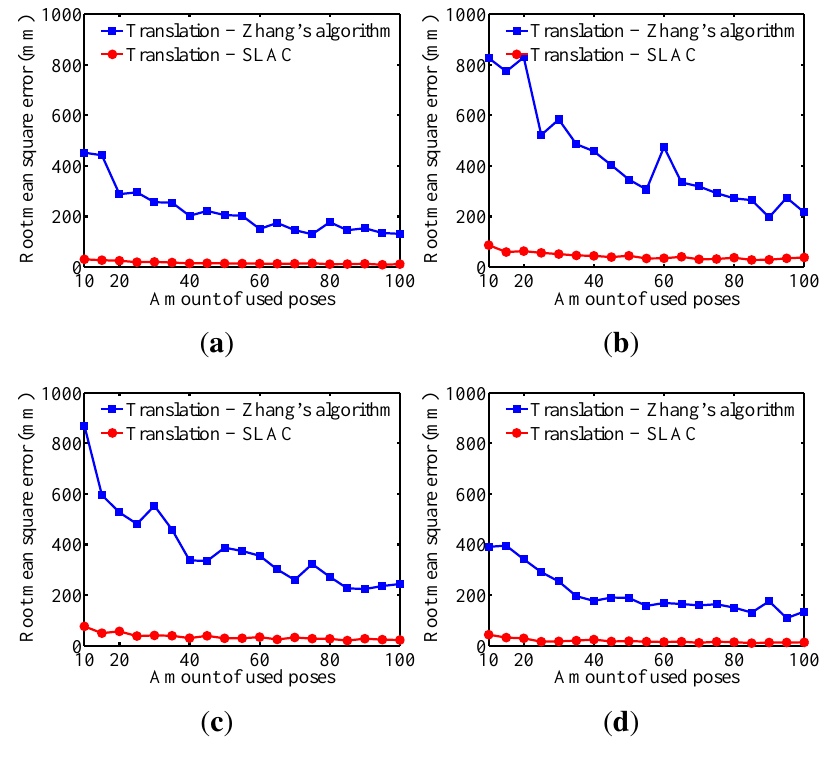
Figure 15. Simulation results for the translation parameters for different amounts of used poses. ( a ) Camera 1; ( b ) Camera 2; ( c ) Camera 3; ( d ) Camera